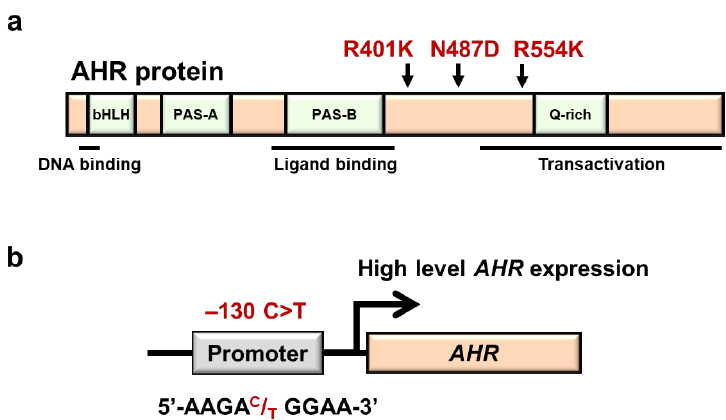
Figure 6. Three nonsynonymous SNPs and one regulatory SNP in the AHR gene. ( a ) Location of three nonsynonymous AHR SNPs associated with AHR domain structures. Human AhR protein contains several functional domains. bHLH, basic helix-loop-helix; PAS, P-ARNT-S; Q-rich, glutamine rich. ( b ) Location of rSNP-130 in the AHR gene. This rSNP has been shown to increase transcriptional regulation of the AHR gene.